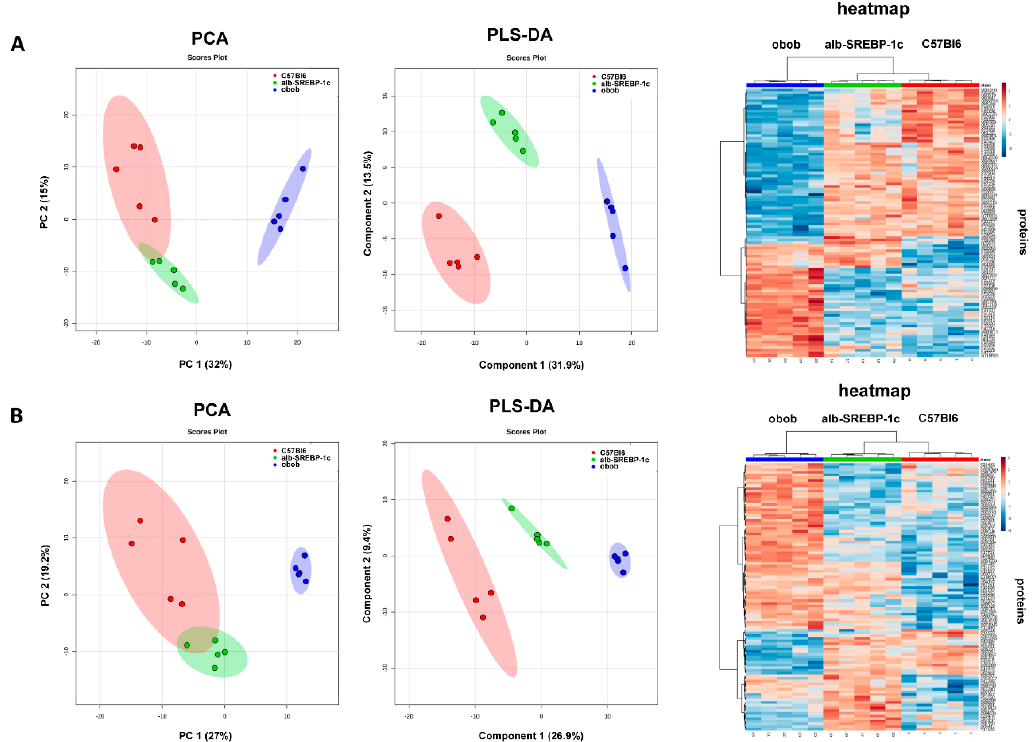
Figure 3. Classification of the mouse models according to the identified differential adipokinomes: ( A ) classically or non-classically secreted (SP +/ SP − ) proteins and ( B ) NP proteins. Principal component analyses (PCA), partial least square discriminant analyses (PLS-DA), and a heat map of the top 100 proteins with the greatest difference (ANOVA).